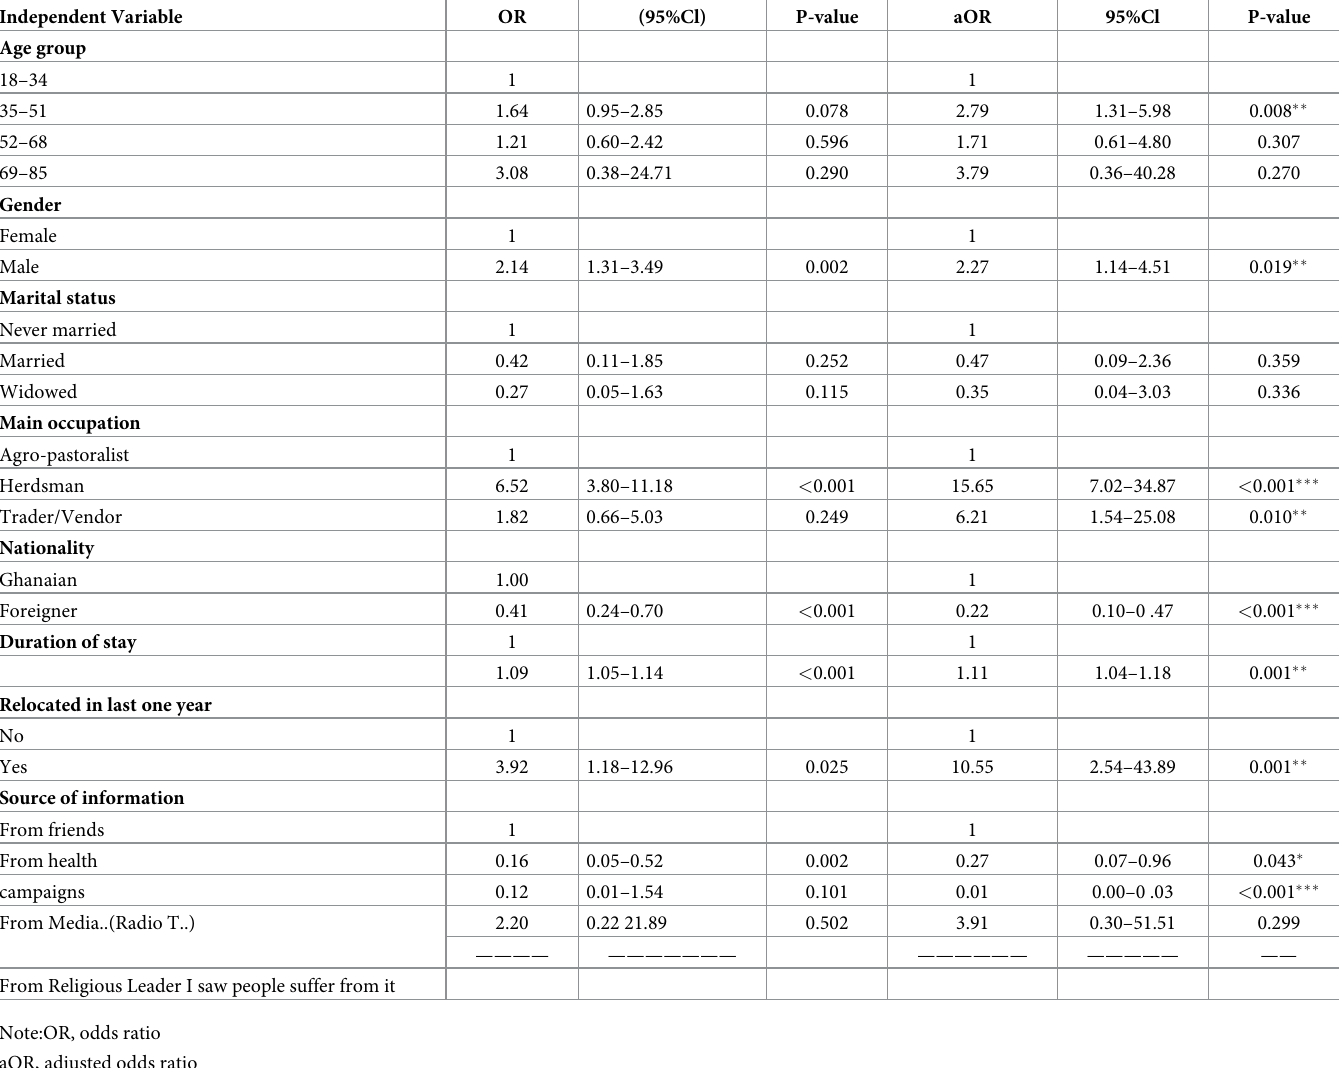
Table 4. Bivariate and multivariate logistic regression analyses showing predictors of attitudes towards yellow fever in the West Gonja Municipal, Ghana,